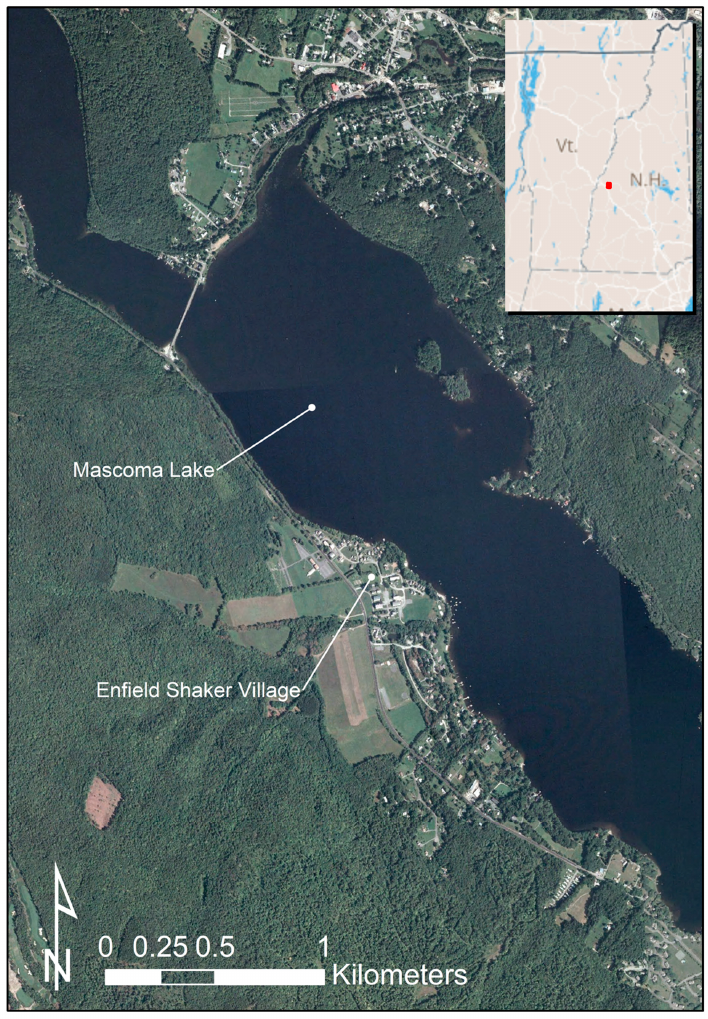
Figure 1. Location of Enfield Shaker Village (2003 National Agriculture Imagery Program basemap courtesy of New Hampshire GRANIT).